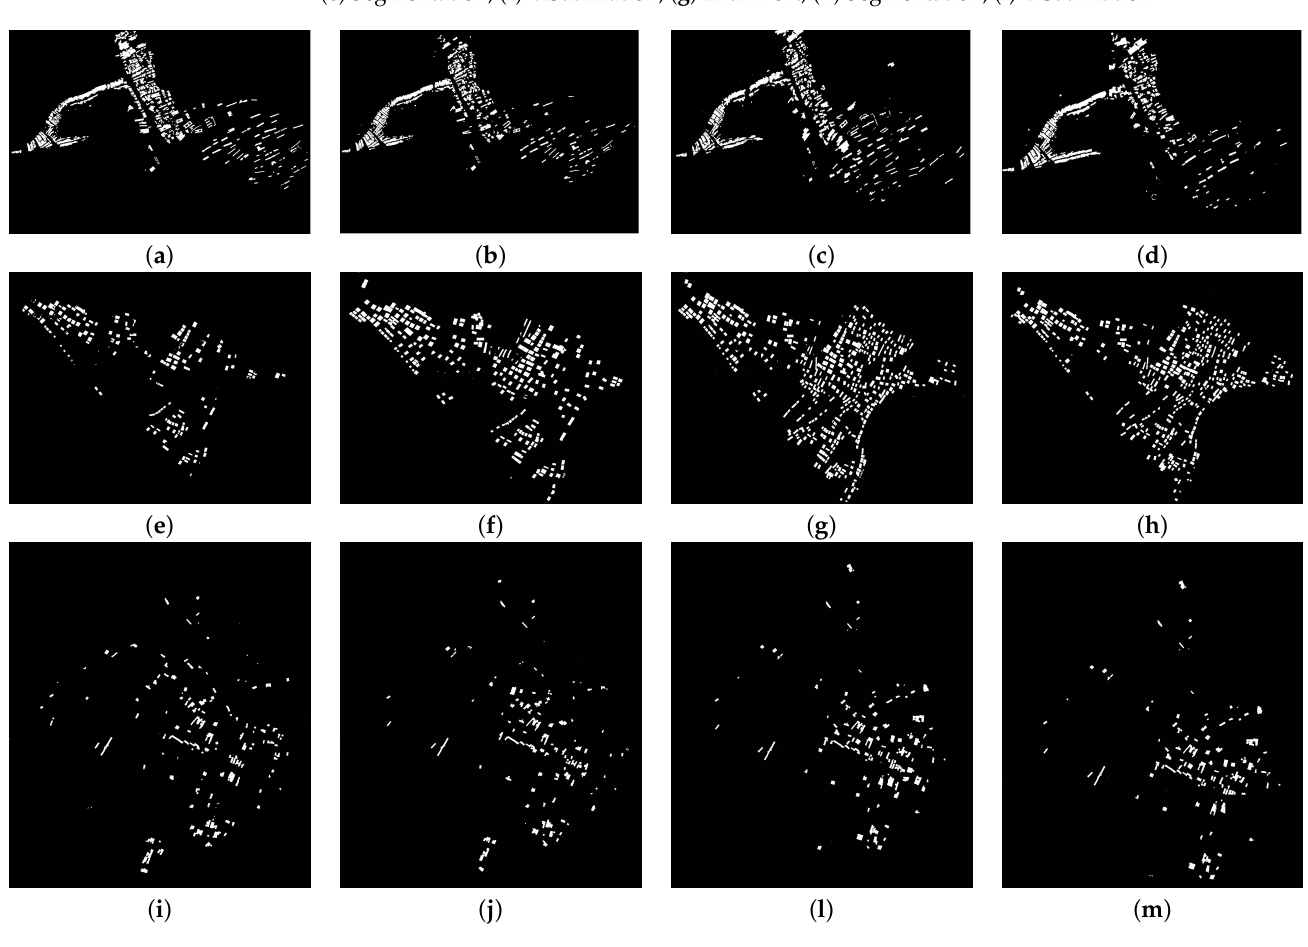
Figure 10. The breeding situation of different ports. ( a ) Xincun Port (2017); ( b ) 2018; ( c ) 2019; ( d ) 2020. ( e ) Potou Port (2017); ( f ) 2018; ( g ) 2019; ( h ) 2020. ( i ) Li’an Port (2017); ( j ) 2018; ( k ) 2019; ( l )